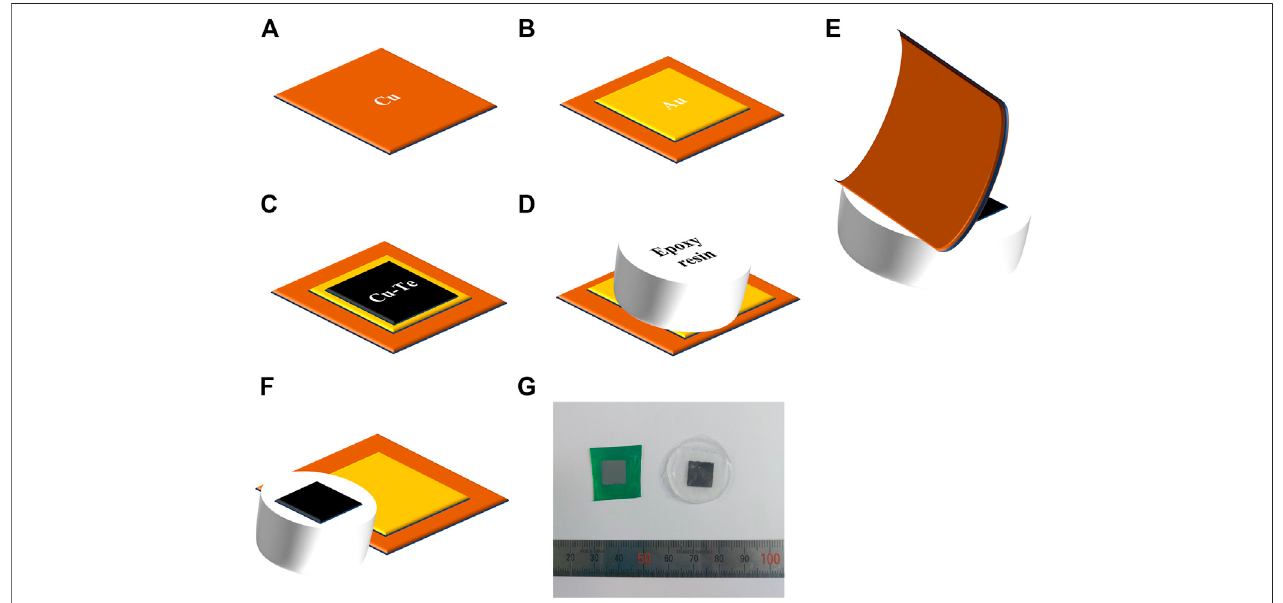
FIGURE 1 | Schematic depicting mechanical exfoliation: (A) Cu foil, (B) Au seed layer obtained by e-beam evaporation, (C) Cu-Te electrodeposition, (D) pasting anddryingofepoxyresin, (E) mechanicalexfoliation, (F) aftermechanicalexfoliation, (G) photographofelectrodepositedCu-Tethin fi lm(left)andmechanicallyexfoliated fi lm on epoxy resin (right).